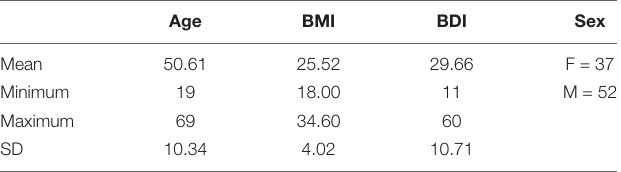
TABLE 1 | Basic characteristics of the study population. Age BMI BDI